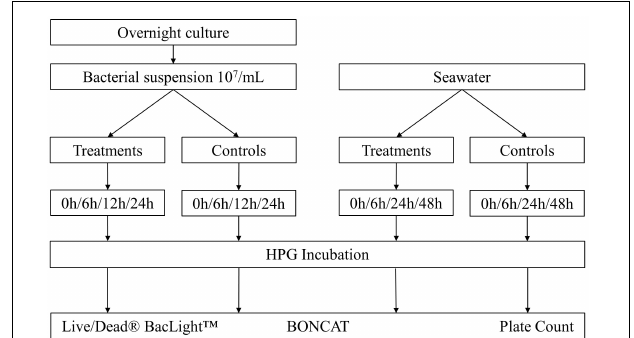
FIGURE 1 | Overview of the experimental setup. Escherichia coli was diluted in 1x PBS to a final concentration of 10 6 –10 7 bacteria/ml. Seawater was directly analyzed after 100 µ m prefiltering. Different treatments were applied: UV irradiation with UV doses of 25, 50, 75, 100, and 200 mJ/cm 2 ; heat treatment at 55 ◦ C for 15, 30, and 45 min. Controls without treatment were incubated with HPG (positive control) and without HPG (negative control). Dead controls with fixed cells (DF) and heat inactivation (3 min at 80 ◦ C) (DT) were added for comparison. Samples were analyzed with plate counts, LIVE/DEAD R (cid:13) BacLight TM staining with PI/SYTO9, and